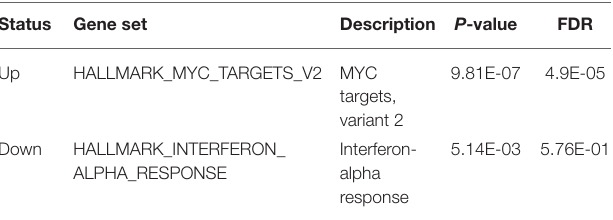
TABLE 2 | Hallmark gene sets identified by OEA (FDR <